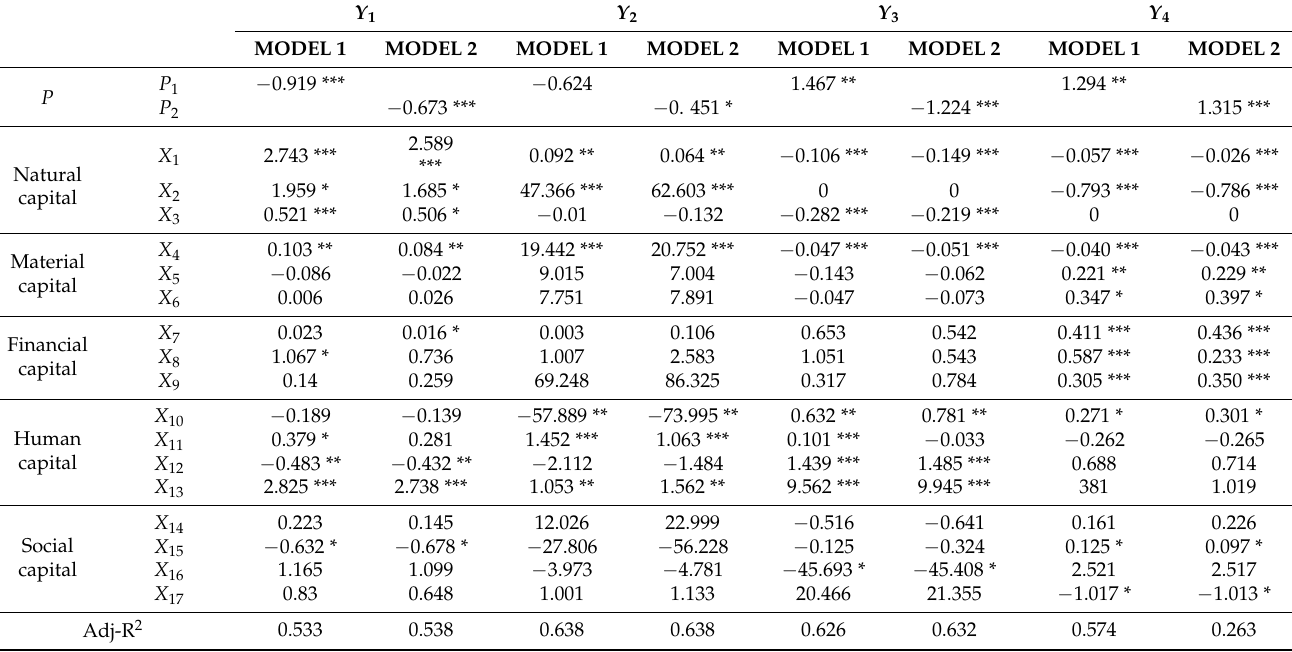
Table 6. Regression results of the impact of ecological compensation on choice of livelihood